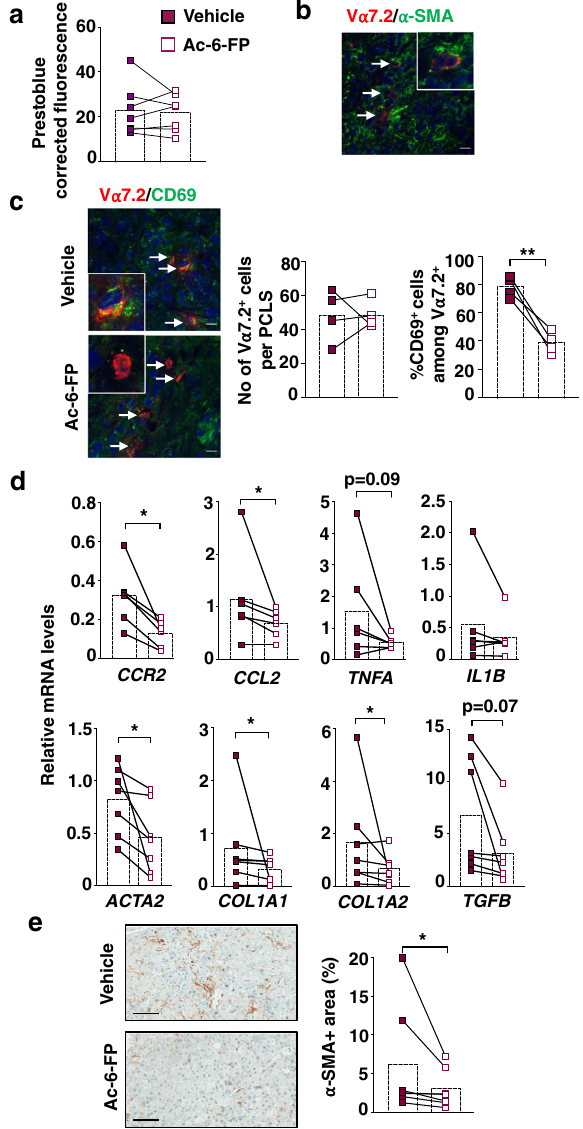
Fig. 1 | Ex vivo exposure of PCLS from patients with chronic liver injury to the MR1-blocking ligand Ac-6-FP decreases the expression of in fl ammatory and fi brogenicgenes. HumanPCLSwereincubatedwith10 µ MAc-6-FPoritsvehiclefor 48h. a PCLS viability was assayed using PrestoBlue ™ Cell Viability assay by fl uor- escence. b MAIT cell localization was evaluated by immuno fl uorescent co-staining of V α 7.2 and α -SMA. A representative image of two experiments is shown. c Representative images and quanti fi cation of V α 7.2+ cell number per PCLS and % CD69+V α 7.2+ activated cells. Results are expressed as % of CD69 + V α 7.2 + /total V α 7.2 + cells. Each point is the mean value per PCLS. d Expression of in fl ammatory and fi brogenic genes in PCLS normalized to housekeeping gene